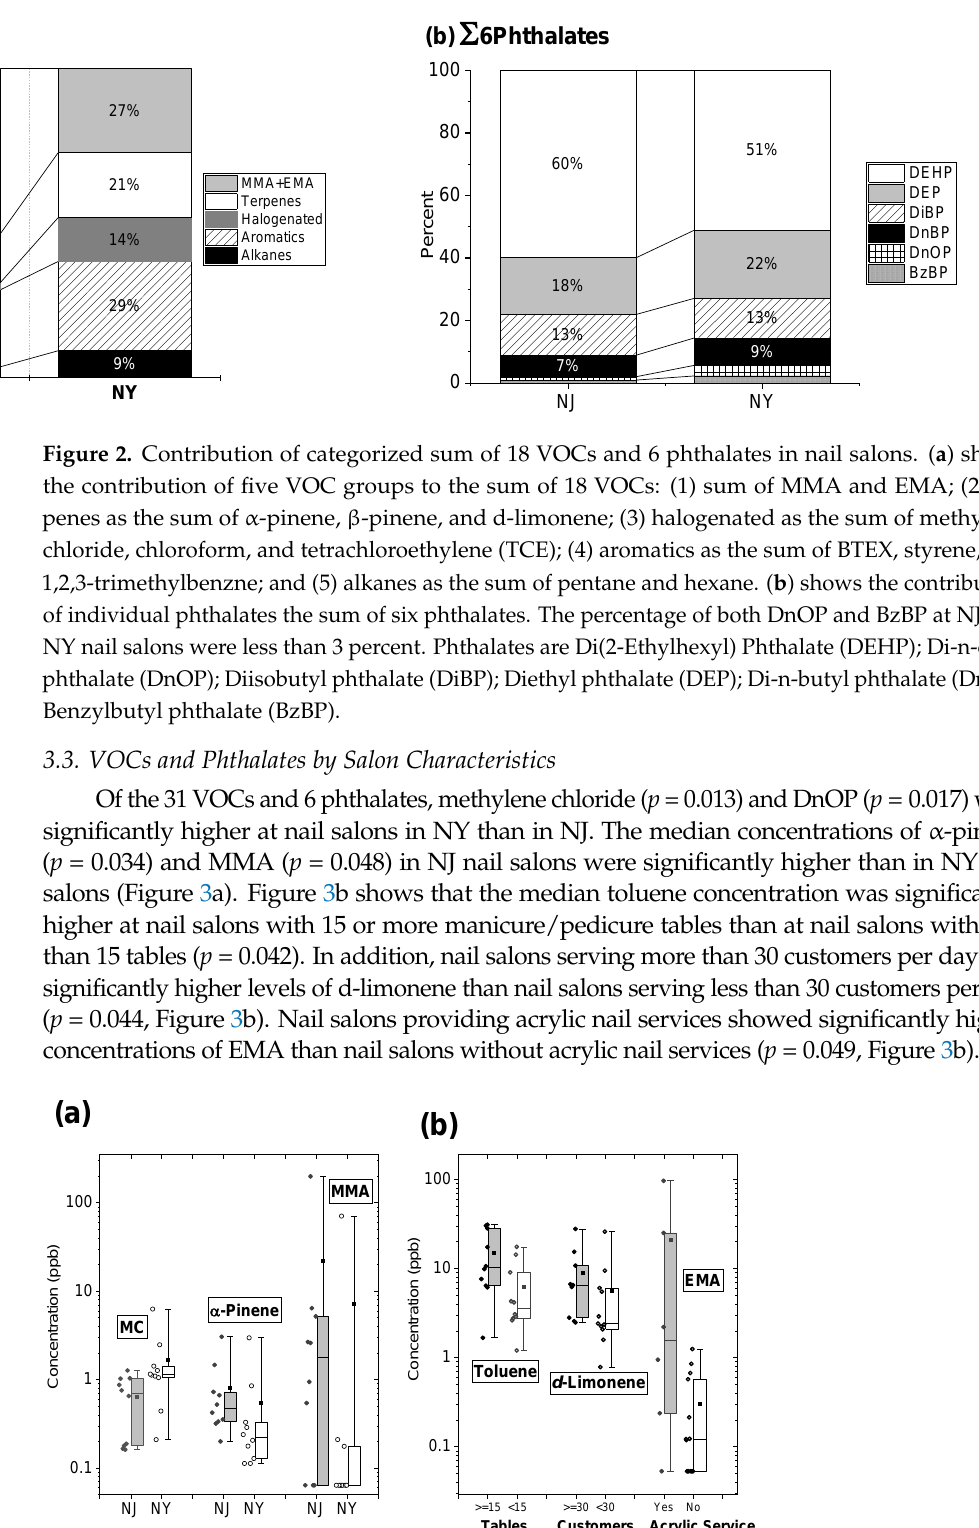
aromatic hydrocarbons (29%), MMA + EMA (27%), terpenes (21%), halogenated VOCs